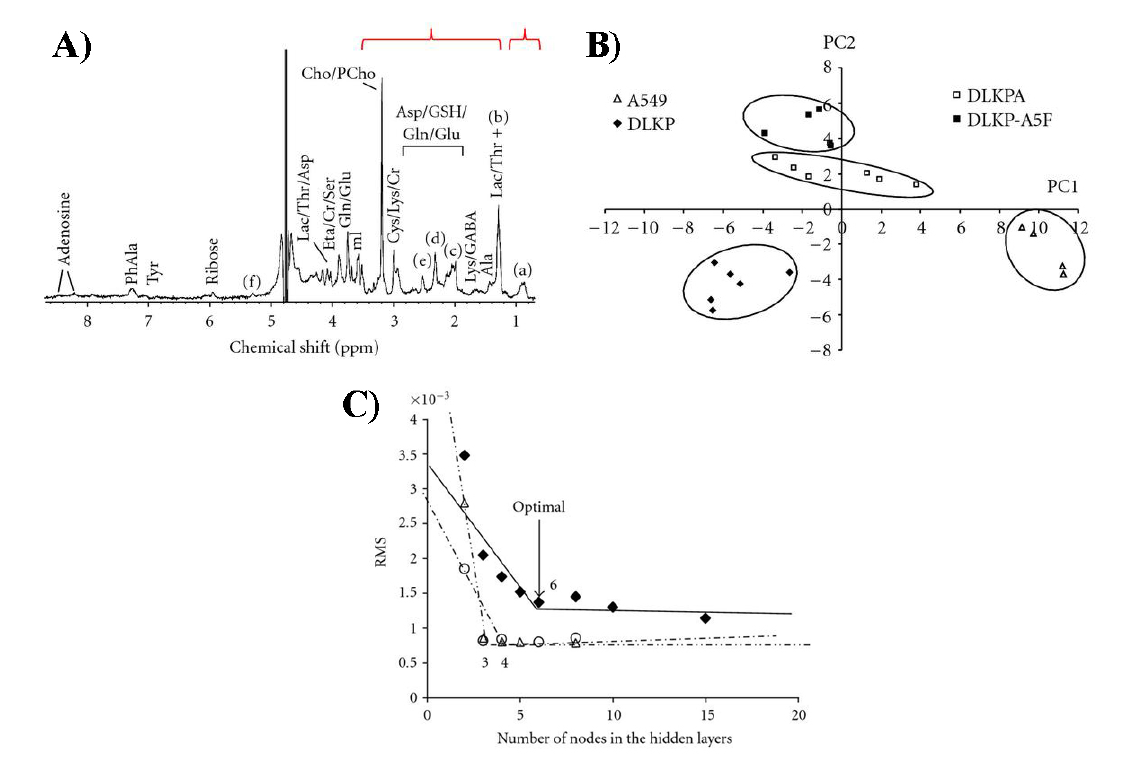
Figure 25. ( A ) Example of 1 H NMR spectrum for DLKP lung carcinoma cells. Labeled peak corresponds to (a) CH 3 , (b) CH 2 , (c) CH 2 CH=CH, (d) CH 2 COO, (e) =CHCH 2 CH=, and (f) HC=CH/CHOCOR. The highlighted intervals at 0.60–1.04 and 1.24–3.56 ppm were used for statistical analysis. ( B ) PCA score plot including data from all four cell lines. ( C ) Residual mean squares error vs. nodes number in the hidden layers, for the 3-layers (full symbols), and in the second (empty triangles) and third (empty circles) layer for the 4-layers networks. Figure reprinted from Ref. [127] under the terms of the Creative Commons Attribution